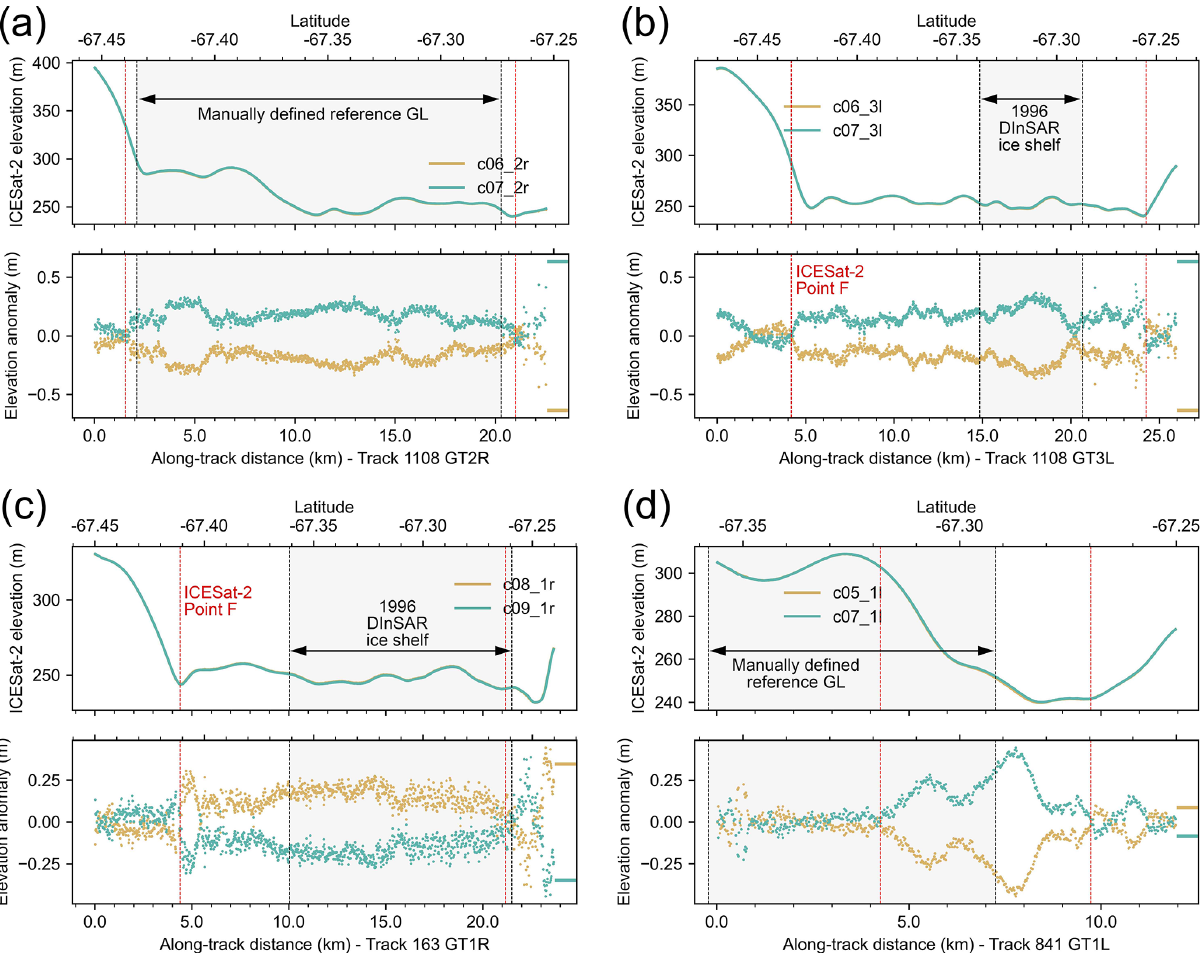
Figure 4. The ICESat-2 elevation anomaly analysis for different elevation profiles on the main glacier trunk of this Moscow University Ice Shelf (MUIS) shown in Fig. 2a, including track 1108 GT2R (a) , track 1108 GT3L (b) , track 163 GT1R (c) , and track 841 GT1L (d) . For all subplots, the upper panel shows the along-track ICESat-2 surface elevation and the lower panel shows the elevation anomalies, the ICESat-2-derived Point F location is shown as the vertical red dashed line, and the zero mean ocean tidal amplitudes predicated from the CATS2008 tidal model at the location of − 67 . 0714 ◦ S, 120.6249 ◦ E are shown as the horizontal line segments on the right side of the bottom panel of each